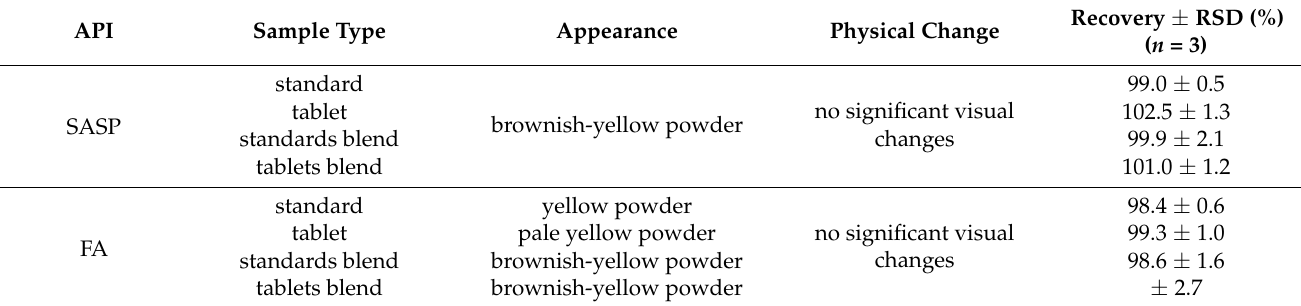
Table 3. Results of the chromatographic analysis after isothermal stress testing